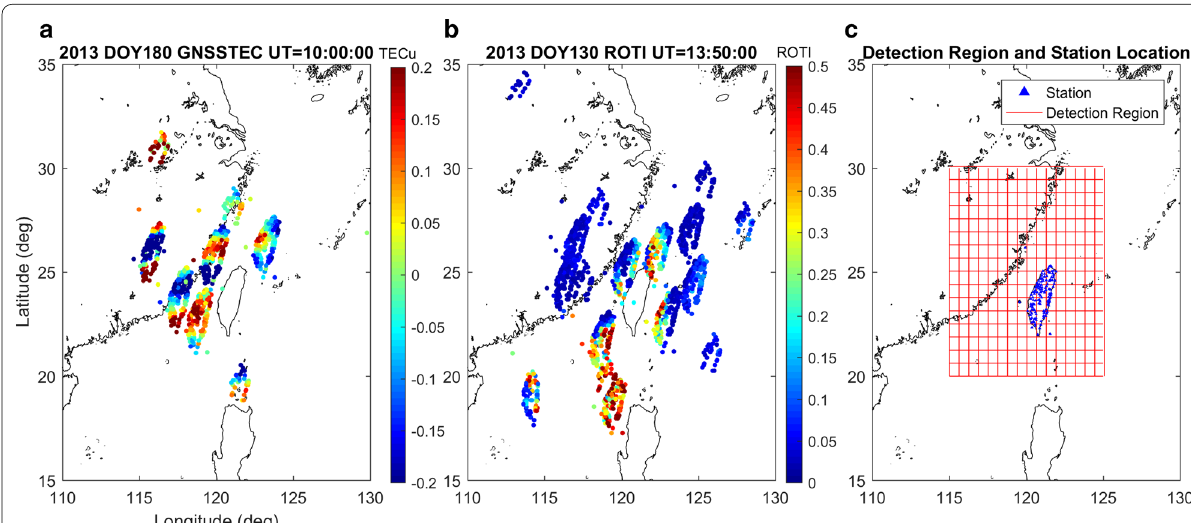
Fig. 1 Example of MSTIDs and EPBs detected by the autonomous algorithm developed in this study and are, respectively, presented in a a 60 min. high‑pass filtered GNSS‑TEC for highlighting the features of MSTIDs and b the rate of TEC index (ROTI) for highlighting the structure of EPBs. The horizontal ranges and grids of the ionospheric phenomena detection (red lines) and the location of the GNSS stations (blue triangles) used in this study are presented in c with the latitude and longitude range of 20–30° N and 115–125° E and ~ 0.5 degree resolution for both zonal and meridional